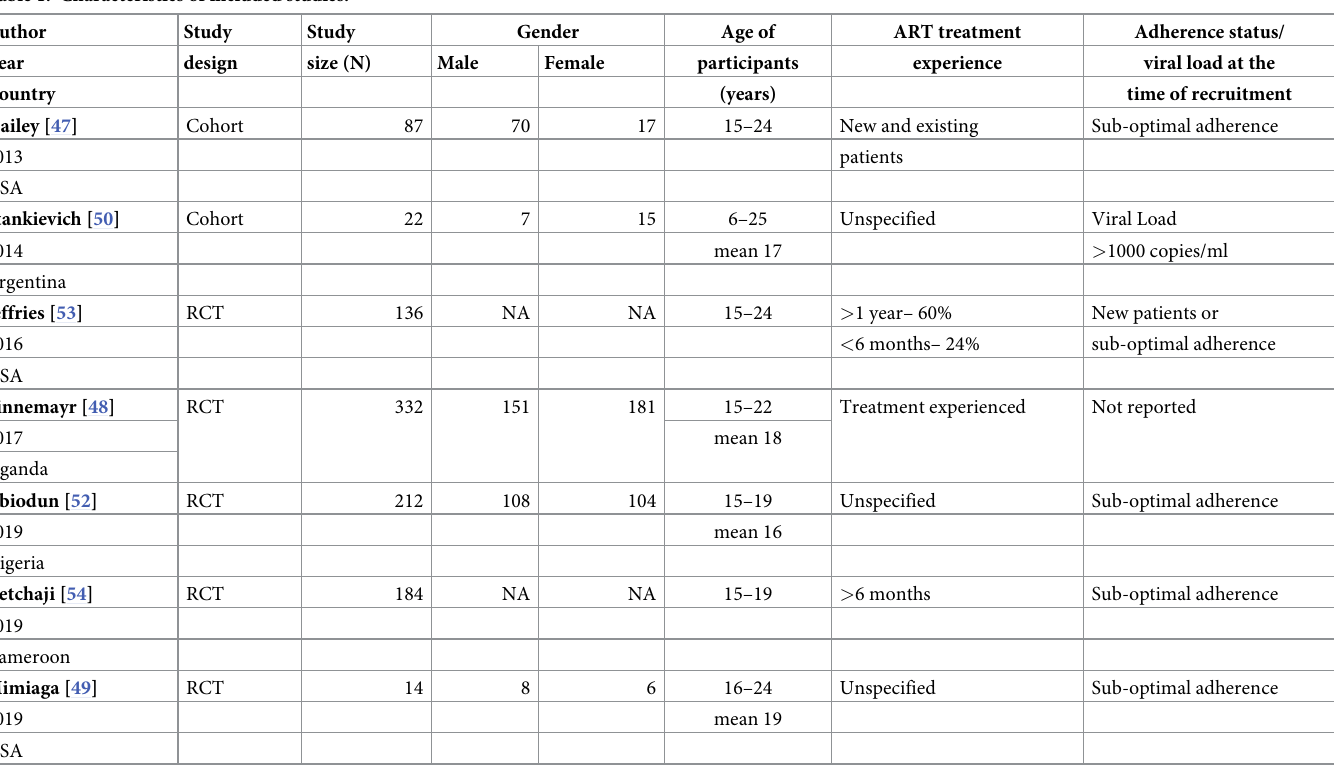
Table 1. Characteristics of included